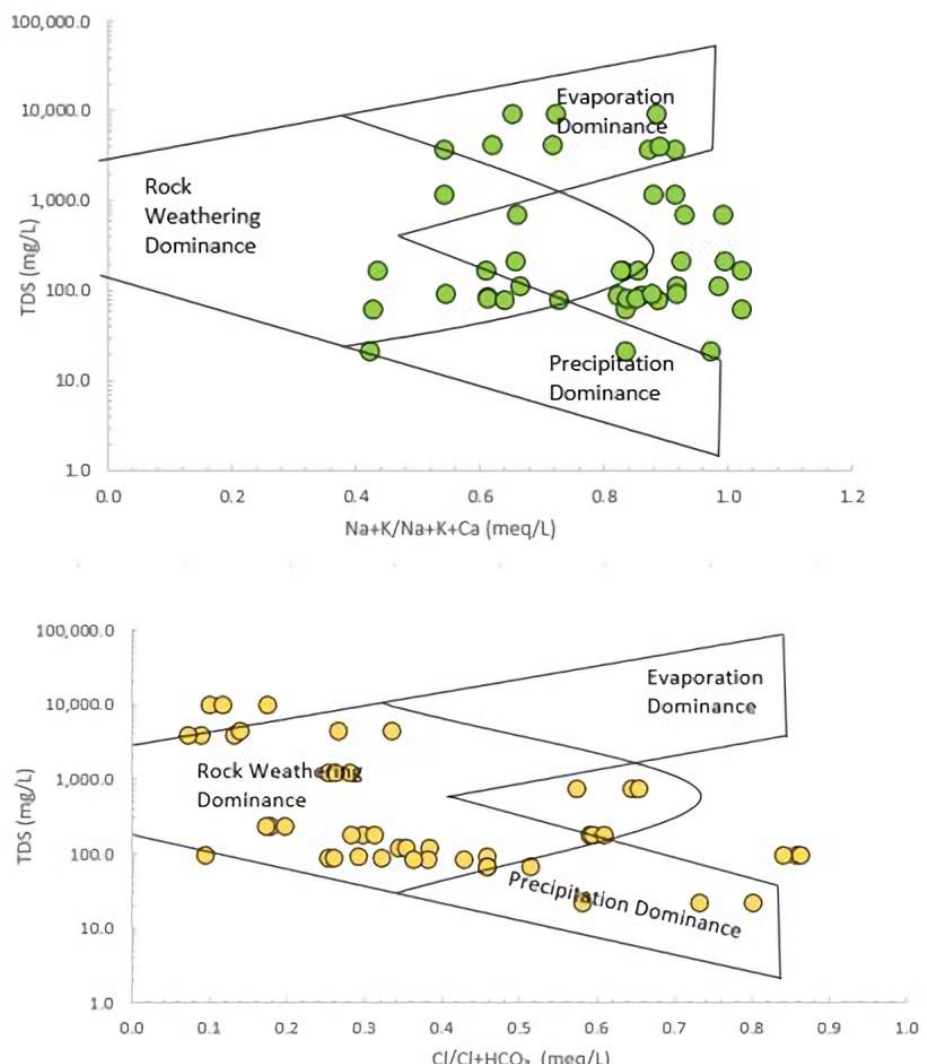
Figure 3. The Gibbs diagram showing the mechanism governing groundwater chemistry